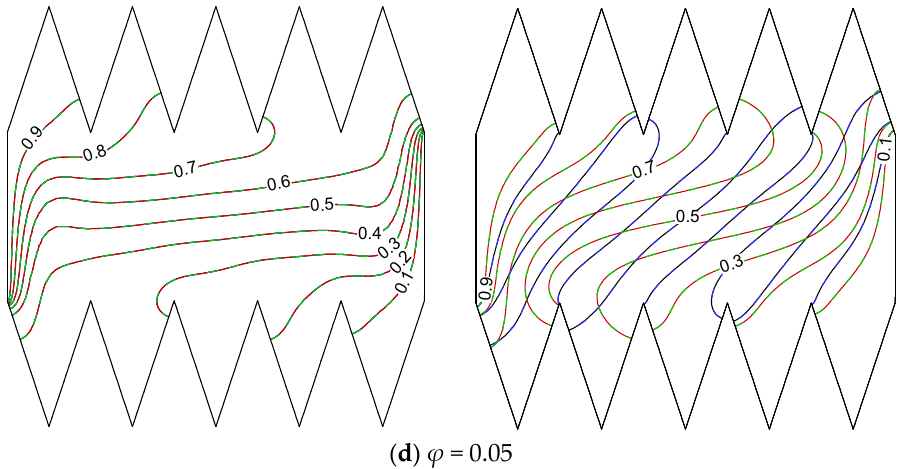
Figure 6. Isotherms for various Ha , φ and A/L at Ra = 10 6 , f = 4, black ( t o + t p /4), red ( t o + t p /2), dashed blue ( t o +3 t p /4), dashed green (t o ) for ( a , b ) and ( t o +4 t p /4) for ( c , d ).